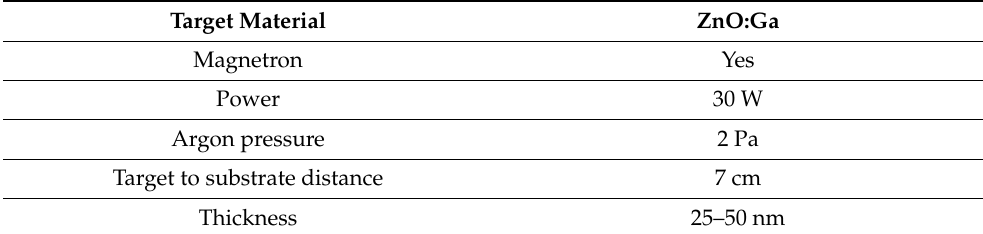
Table 1. Deposition parameters of thin